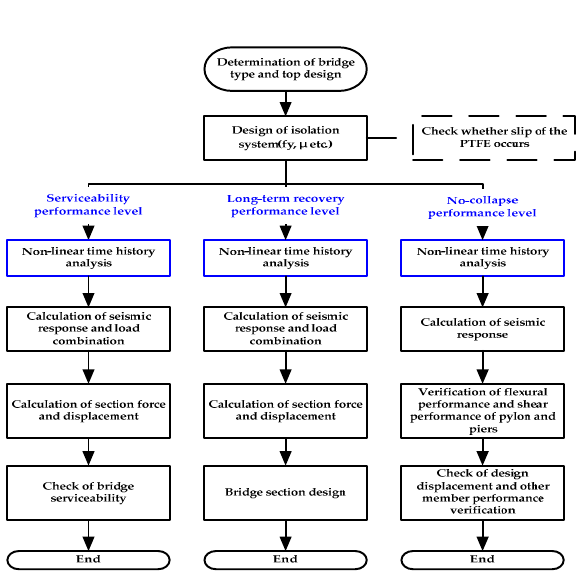
Figure A1. Proposed design procedure for R-FBI (Case I).